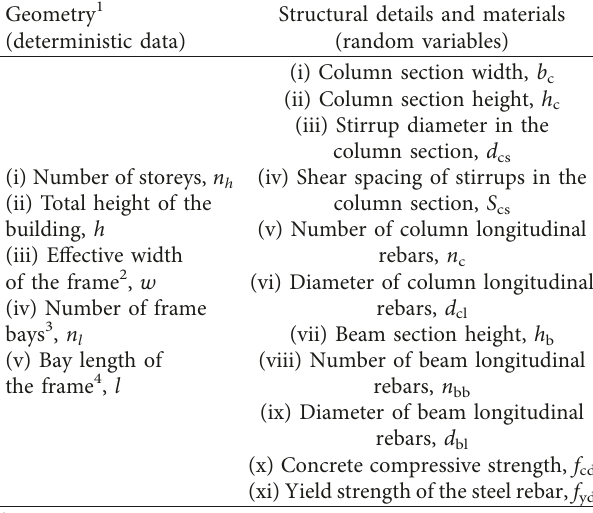
Table 1: Deterministic data and random variables assumed for sampling of